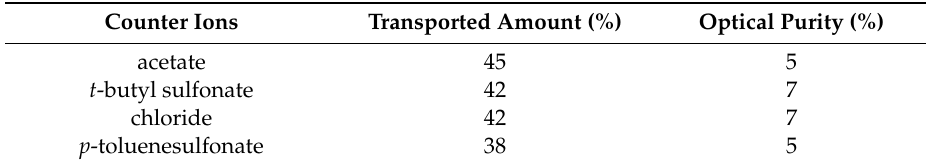
Table 1. Effect of counter ions on the transport of racemic protonated NEA ( 21 ) after 10 h of transport time using macrocycle ( R , R )- 2 as a carrier.